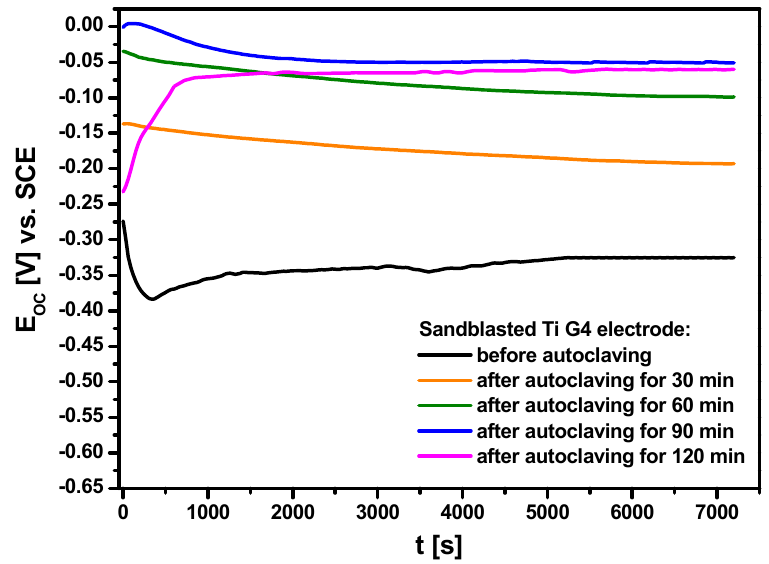
Figure 7. Open circuit potential as a function of immersion time for the sandblasted Ti G4 electrode in ASS at 37 °C.